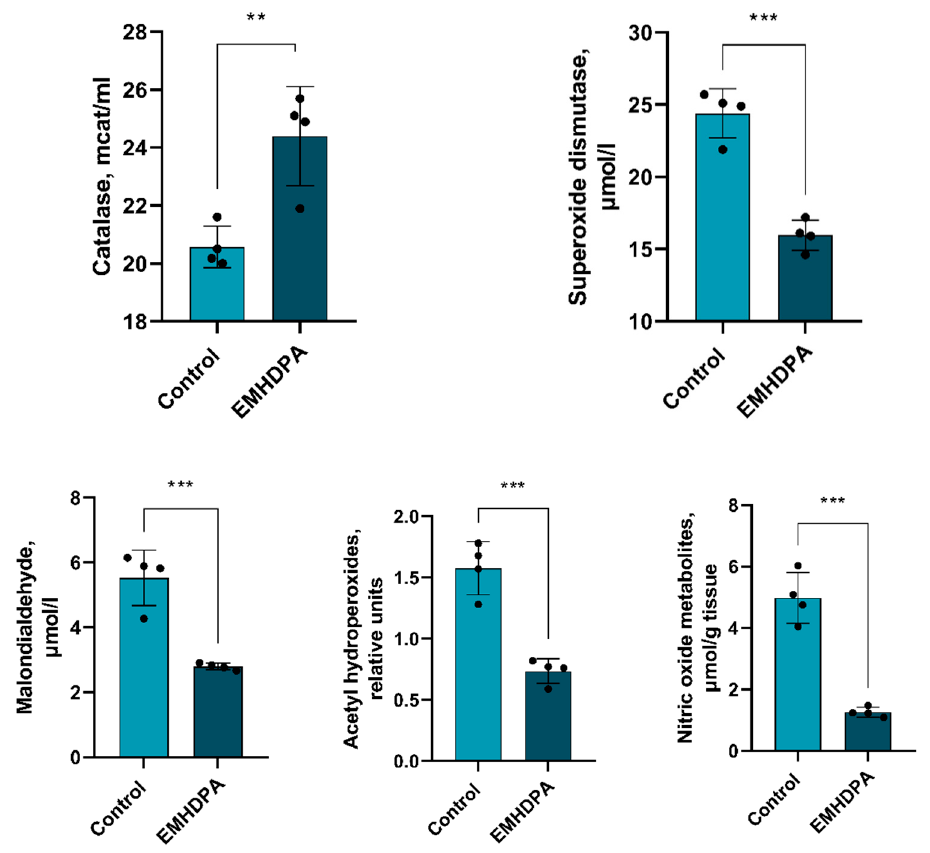
Figure 11. The effect of the studied drugs on the indicators of oxidative stress in the rat brain tissues. Note: **— p < 0.01; ***— p < 0.001